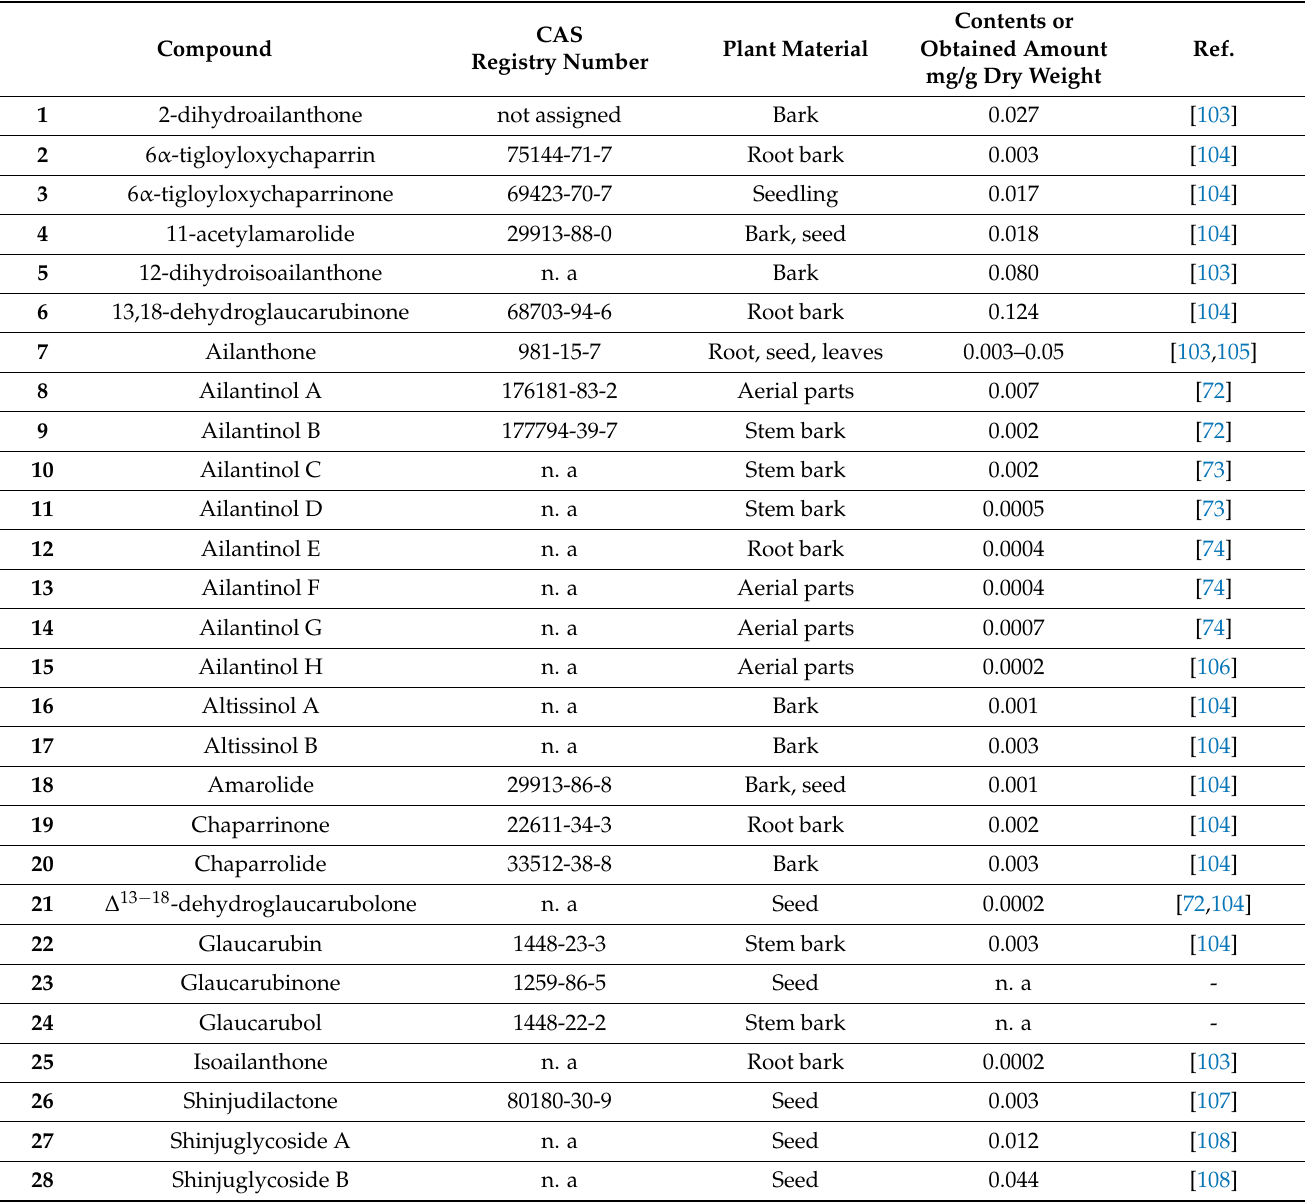
Table 1. List of isolated quassinoids from A. altissima